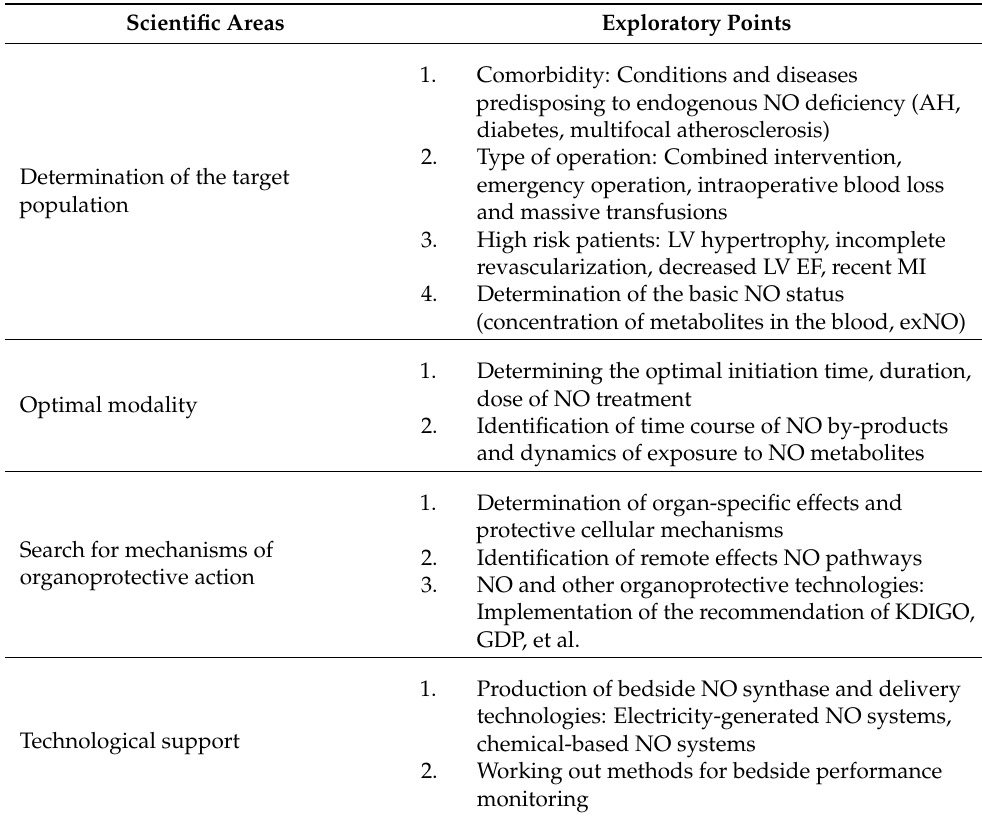
Table 4. Future directions. Prospects for further research investigating the beneficial effects of NO in cardiac